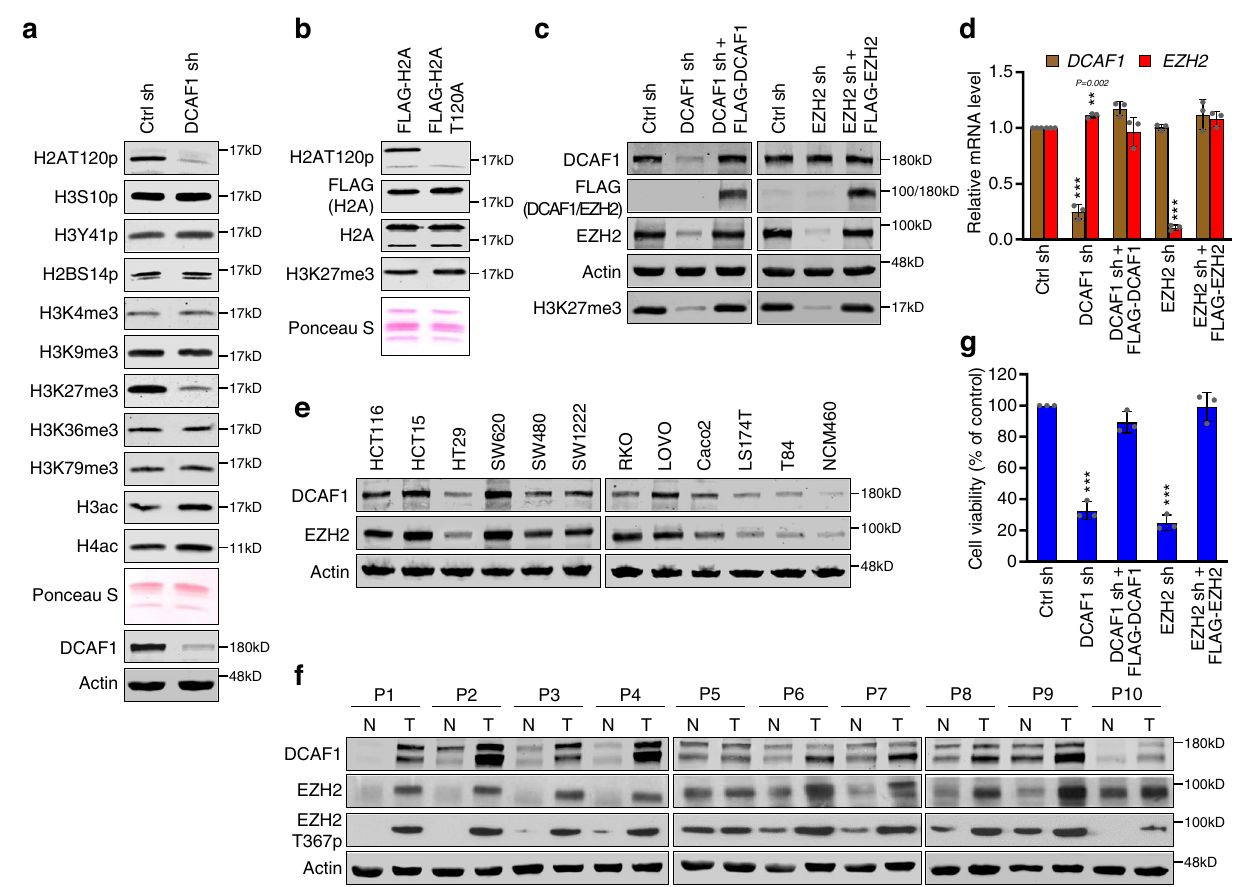
Fig. 1 | DCAF1-dependent increase in EZH2 protein levels in colon cancer cells. a SW620 colon cancer cells were transfected with nontargeting control shRNA (Ctrl) or DCAF1 targeting shRNA, and chromatin fractions were prepared and analyzed by Western blotting with antibodies speci fi c for the indicated histone modi fi cations. The top panel shows a Ponceau S-stained gel of the puri fi ed chro- matin. Shown on the bottom panel is Western blot analysis con fi rming DCAF1 knockdown. Actin was used as a loading control. Data are representative of three independent experiments. b SW620 cells were infected with lentiviruses expres- sing H2A wild type or T120A mutant containing an N-terminal 3×FLAG tag, and nucleosomes were prepared from chromatin fractions. Nucleosomes containing ectopic H2A were immunoprecipitated from total nucleosomes with anti-FLAG antibody. The relative levels of H2AT120p and H3K27me3 in the puri fi ed nucleo- somes were determined by Westernblotting.Histone compositions of the puri fi ed nucleosomes were also analyzed by 15% SDS-PAGE followed by Ponceau S staining (bottom panel). Data are representative of three independent experiments. c Cell lysates and chromatin fractions were prepared from SW620 cells depleted of DCAF1or EZH2 and analyzed by Western blotting with the antibodies indicatedon the left. To rescue the knockdown effects, DCAF1- or EZH2-depleted cells were infected with lentiviruses expressing shRNA-resistant 3×FLAG-DCAF1 or 3×FLAG- EZH2. Data are representative of three independent experiments. (See also